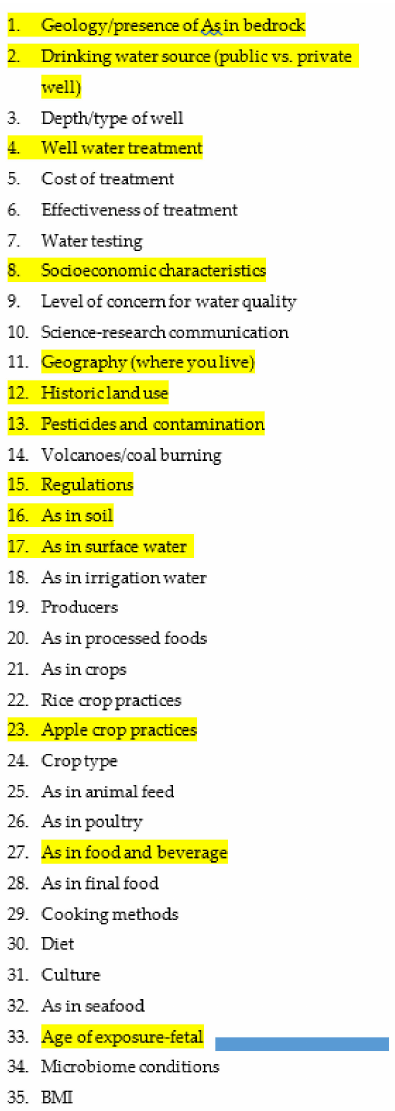
Figure 5. Nodes used to develop community interviews. Highlighted nodes indicate themes that were discussed in both the expert models and the community